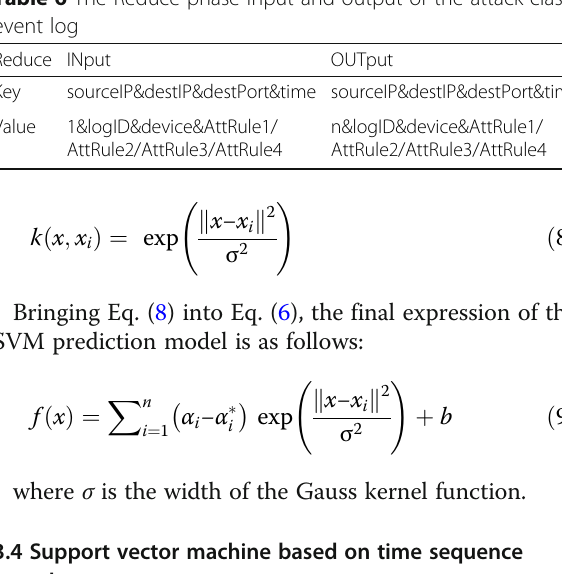
Table 4 The Reduce phase input and output of the traffic